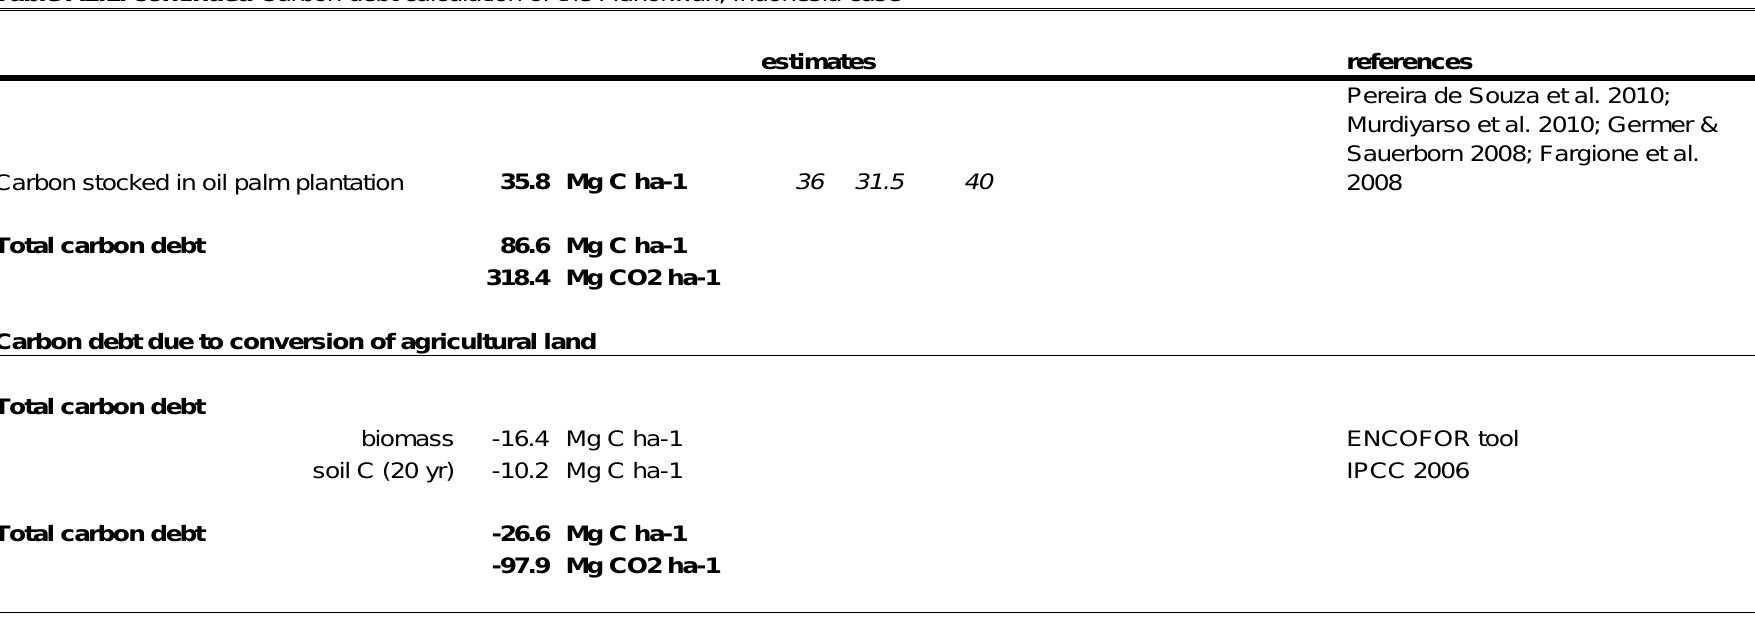
Table A2.1. continued Carbon debt calculation of the Manokwari, Indonesia